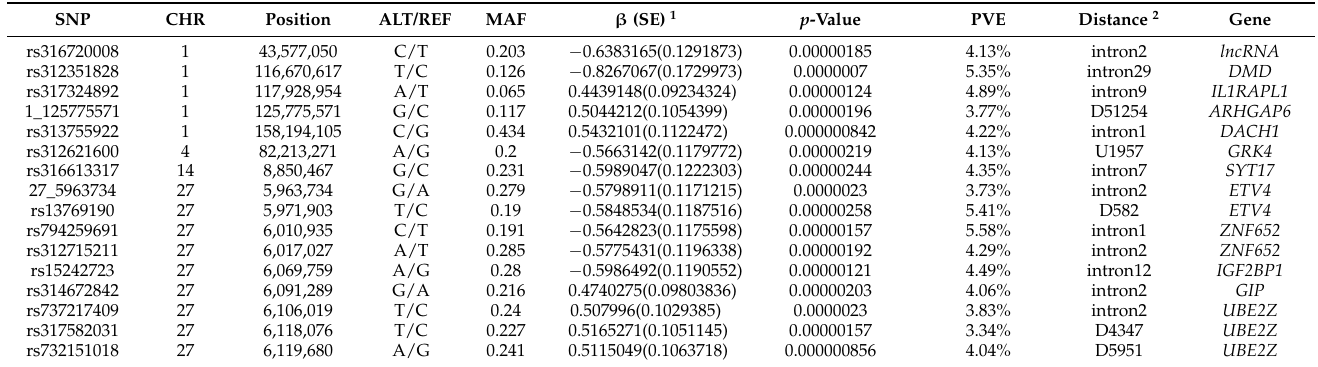
Table 2. Summary of SNPs that reached the suggestive significance threshold on the